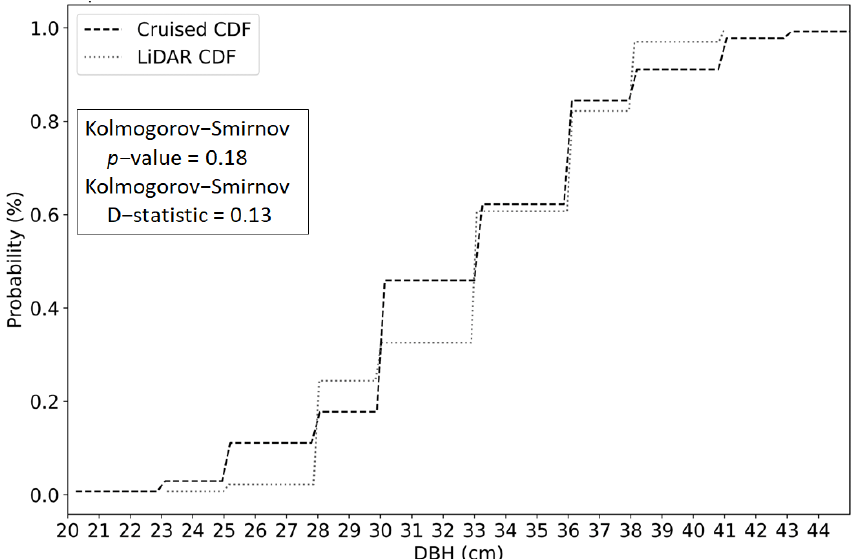
Figure 7. Empirical Cumulative Distribution Function (eCDF) for individual tree DBH values derived from ForestView ® and cruised measurements. Tree DBH values within each dataset generally follow a standard normal distribution and were not significantly different within size classes (Kolmogorov-Smirnov p -value: 0.182, D-statistic: 0.13). The ALS-derived volume of detected trees exhibited a 0.01 m 3 bias and RMSE of 0.15